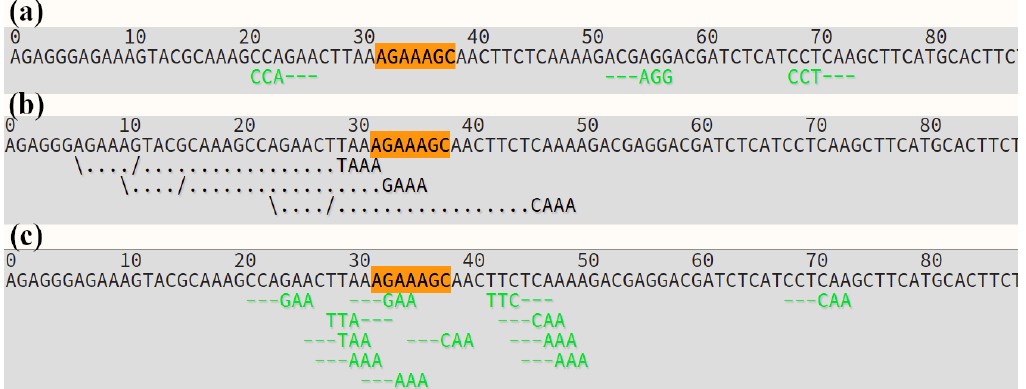
Figure 5. PAM sites in the beginning of the DNA-binding domain of a MYBL2 gene, recognized by ( a ) Cas9, ( b ) Cas12a, ( c ) iSpyMacCas9.